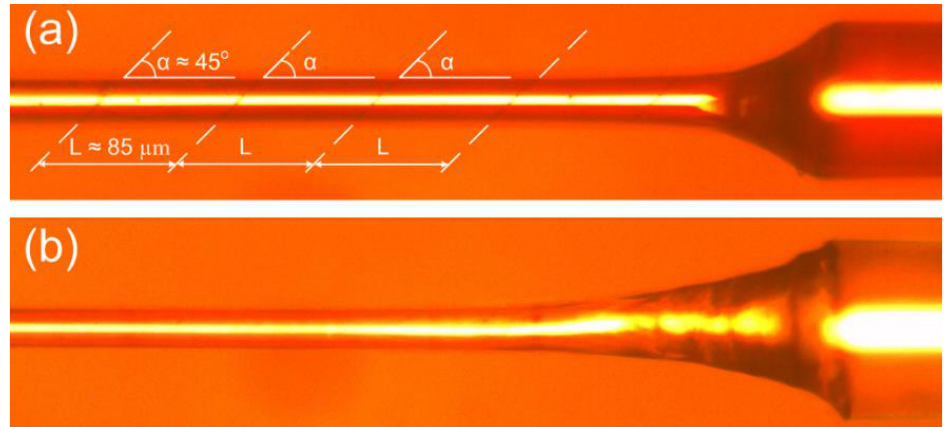
Figure 11. Photographs of sections of the thinned regions of optical fibers coated with ZnTe films of the thickness necessary to observe the first TM LMR in the near-infrared region. The layer is synthesized on the fiber ( a ) without and ( b ) with interruption of the process. The images are taken from different ends of the optical fiber etched section.